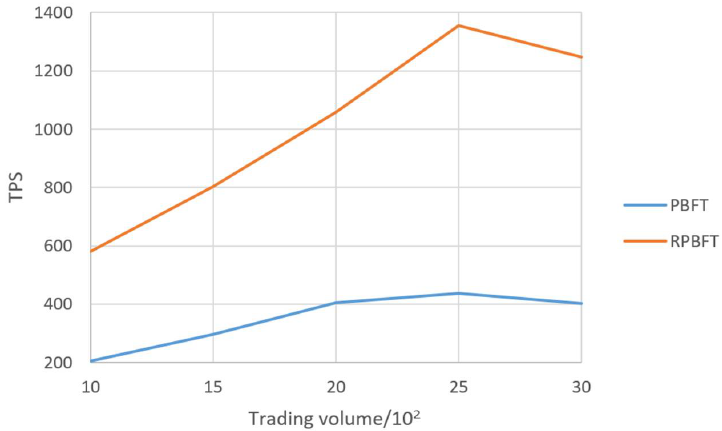
Figure 8. Comparison of TPS under different trading volumes.